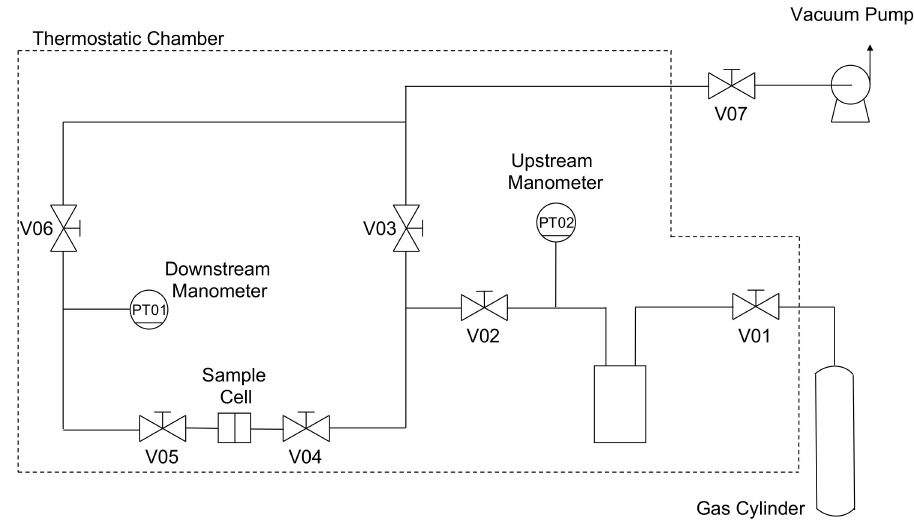
Figure 2. Layout of the permeation equipment. The outer black dashed line indicates the volume in which temperature is